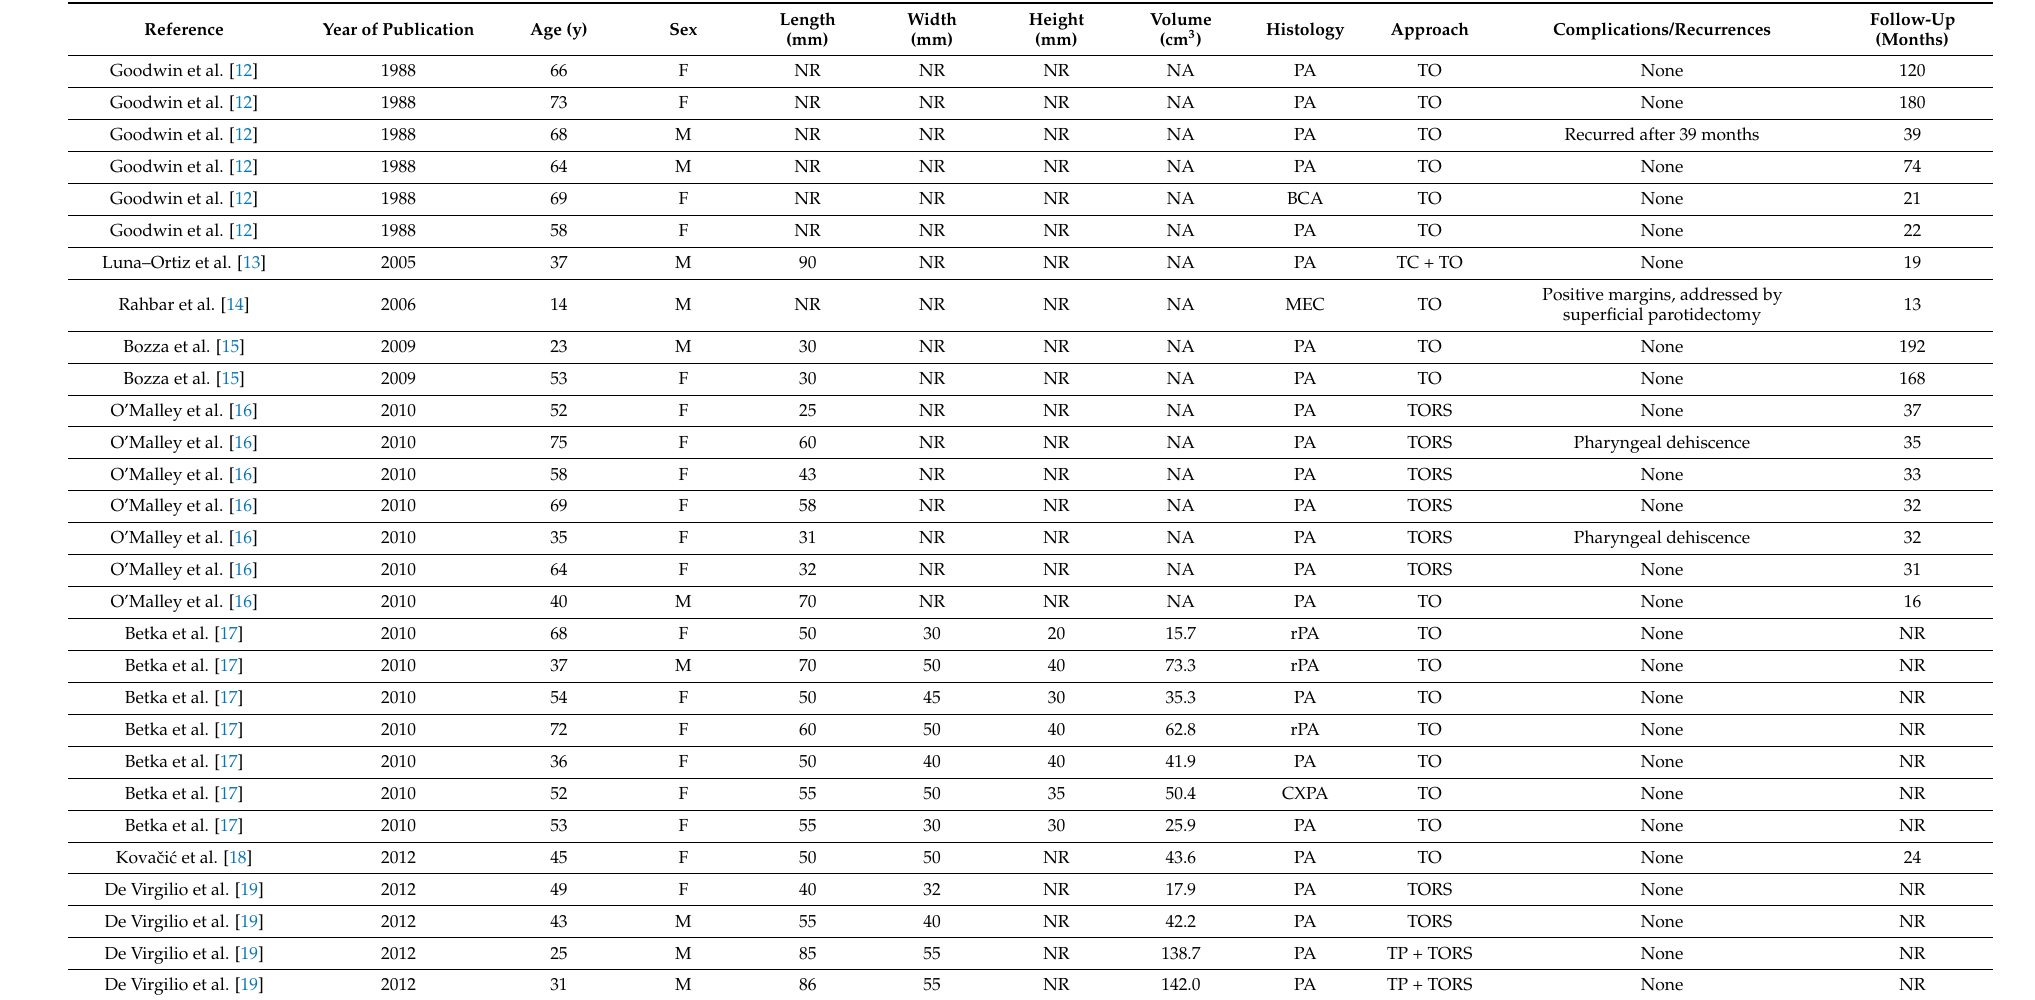
Table 1. Transoral approach to parotid tumors: review of the